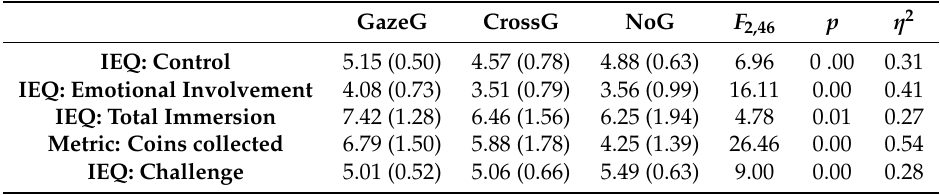
Table 1. Means and Standard Deviation for control (Cont), emotional involvement (EmIn), challenge (Chal) on a scale from 1 to 7; Total immersion (Toim) on a scale from 0 to 10; and coins collected (scale: 0 to 8); ratings are presented per condition (gaze-based guidance (GazeG), crosshair-based guidance (CrossG), no guidance (NoG), Note: N = 24, p <